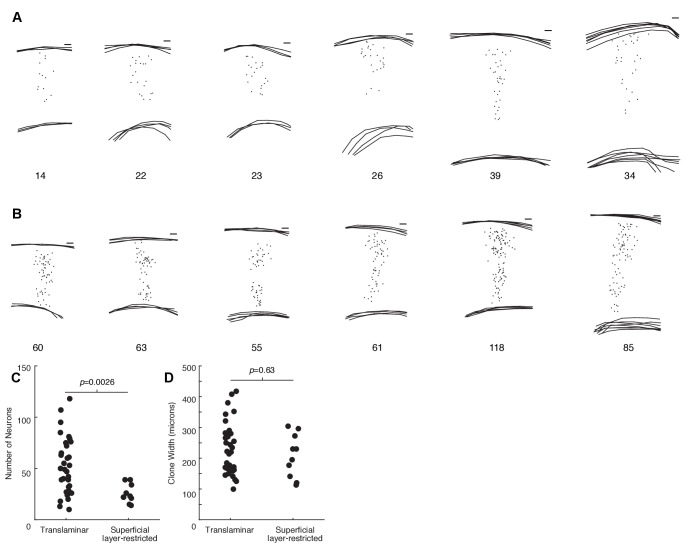
Additional examples and quantitative analyses of clones induced at E11.5 that are missing deep cortical layers, expanding on Figure 1C,F.(A) Additional examples of clones induced at E11.5 that were lacking neurons in the deep cortical layers. (B) Examples of clones induced at E11.5 that were considered translaminar due to inclusion of neurons in both deep and superficial cortical layers. (C and D) Clones lacking deep-layer neurons (incomplete clones) have fewer neurons overall (C) but there is no difference in clone width between superficial layer-restricted and translaminar clones (D; n = 40 and 10 for translaminar and superficial layer-restricted clones; p-values computed using Wilcoxon rank sum test). Scale bars: 100 µm (A and B).